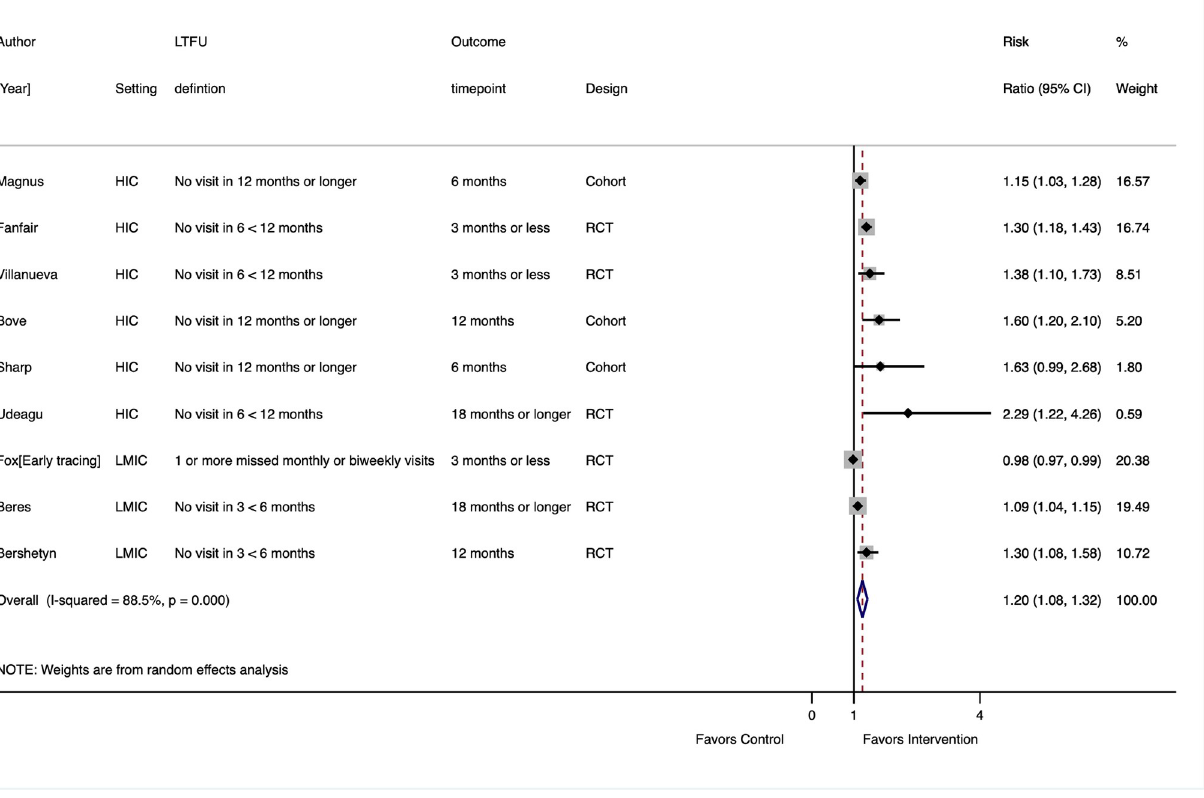
Fig 5. Reengagement program effects (proportion LTFU returned to original clinic), reengagement program versus no intervention or SOC. CI AU : AnabbreviationlisthasbeencompiledforthoseusedinFig 5 : Pleaseverifythatallentriesarecorrect : , confidence interval; HIC, high-income country; LMIC, low- and middle-income country; LTFU, lost to follow-up; RCT, randomized controlled trial; SOC, standard of